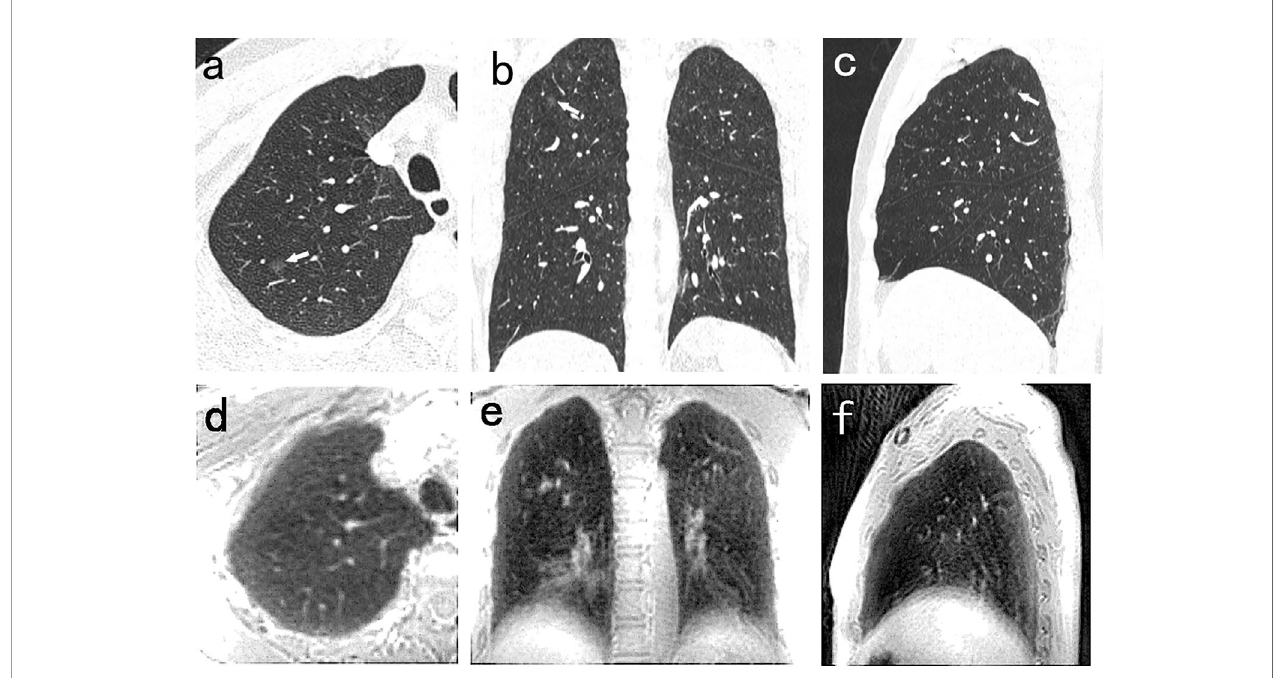
FIGURE 4 | A 54-year-old man with 5.5mm GGN (arrow) in the right upper lobe. The nodule is well visualized on the CT axial (A) , coronal (B) , and sagittal (C) image, and is not detected in the PETRA sequence (D – F) . The arrows represent the locations of